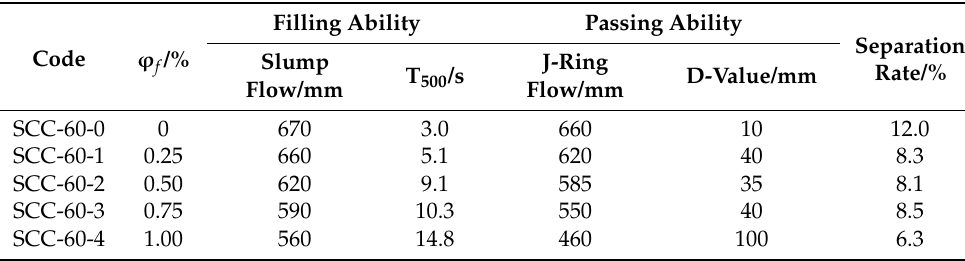
Table 6. Influence of steel fiber volume fraction ( ϕ f ) on workability of SCC containing a high level of fly ash.